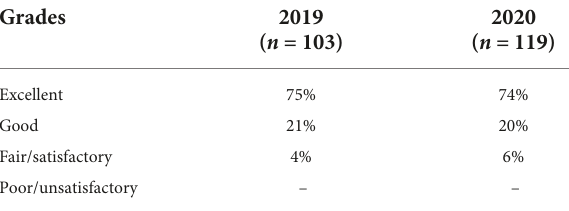
TABLE 5 Results of defending the final qualifying work in the foreign languages at the master level.